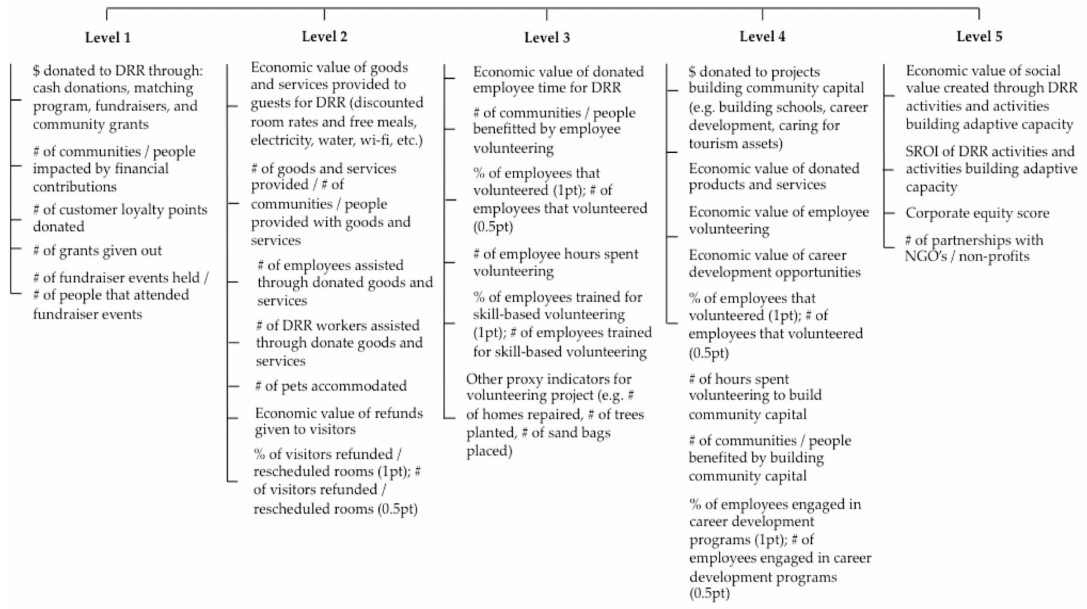
Figure 4. Tiered indicator framework to examine maturity of performance evaluation of hotel corporations’ CSR contributions to disaster relief and